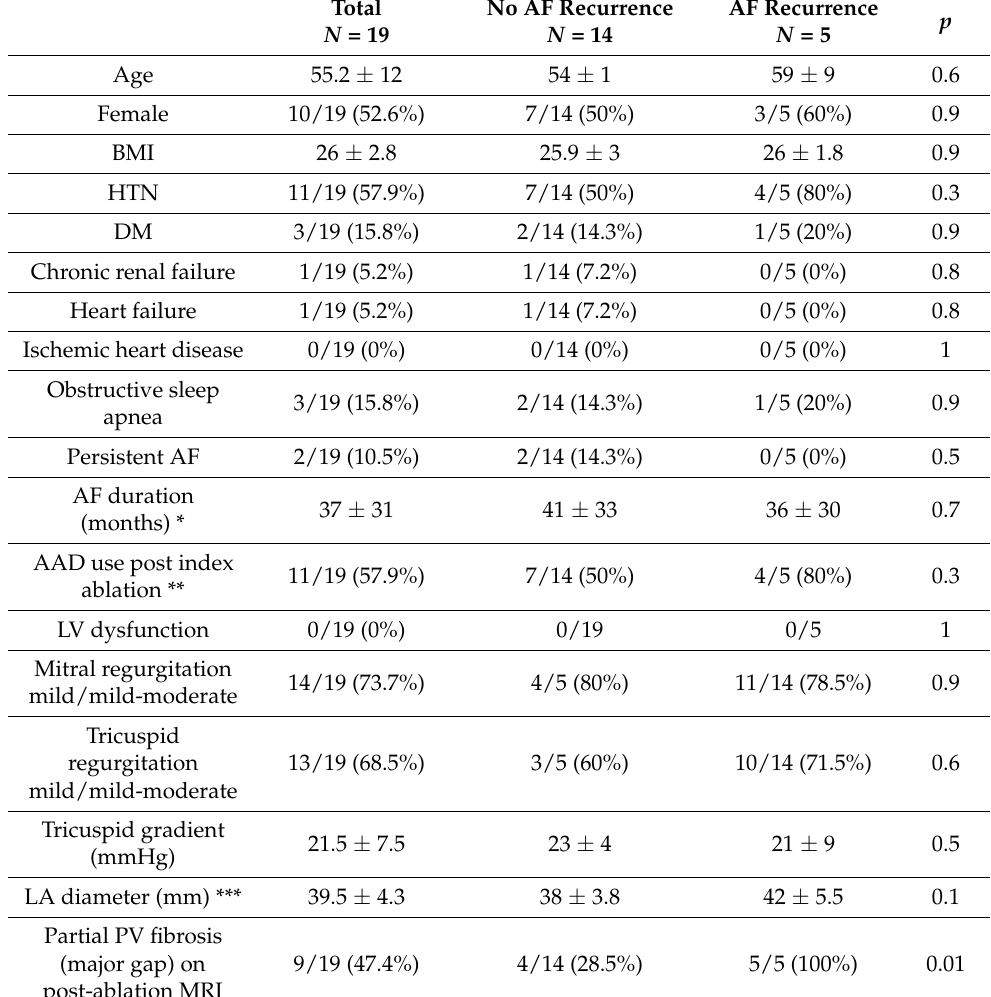
Table 1. Patient data comparison between subgroups with and without one-year AF